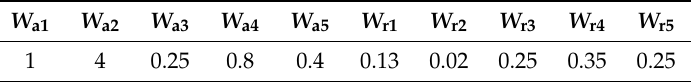
Table 4. Absolute and relative weights of the design indicator.